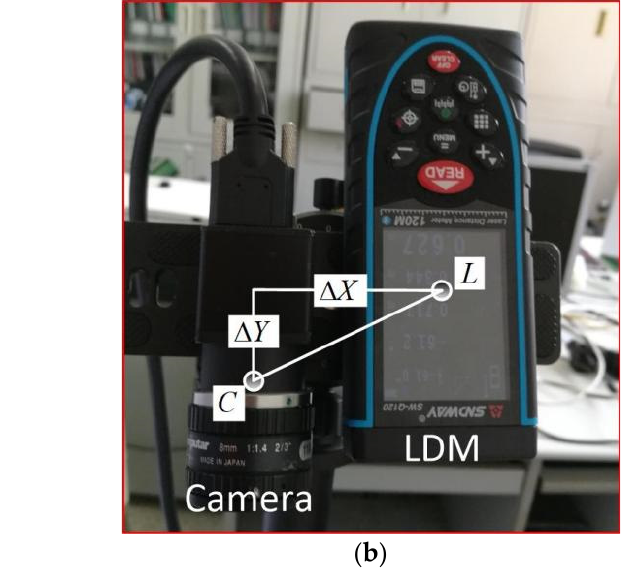
Figure 3. LDM-supported measuring device showing ( a ) structure diagram and ( b ) picture of real device. real